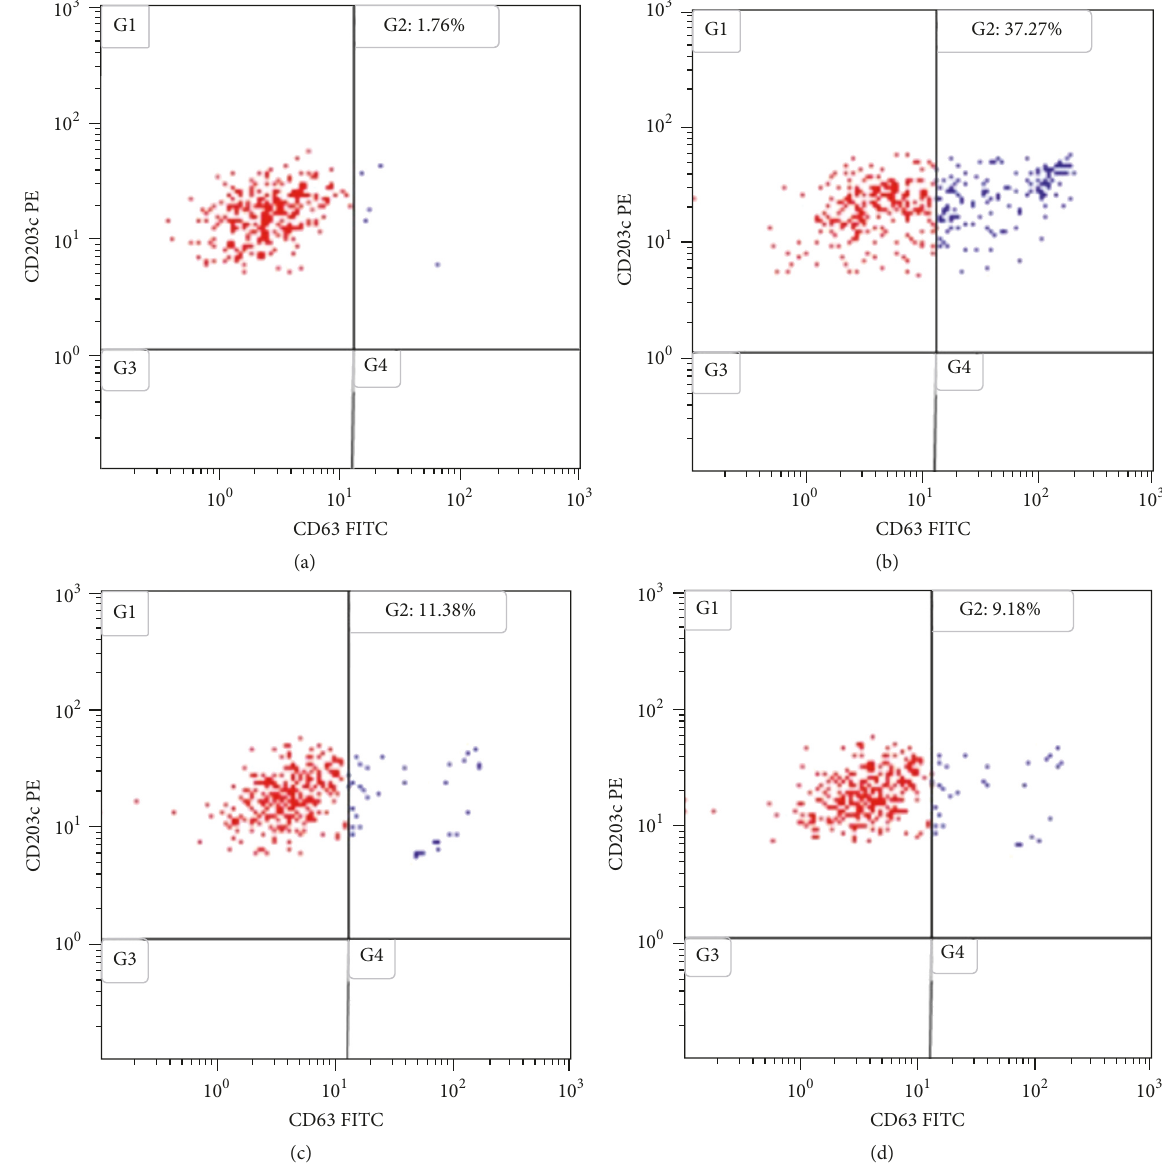
Figure 2: Basophil activation test with maltitol. The G2 quadrant of the dot plots represents the percentage of basophils that expresses CD63 in high intensity (activation of cells). (a) Negative control; (b) positive control; (c) maltitol at 1000 𝜇 g/ml; (d) maltitol at 100 𝜇